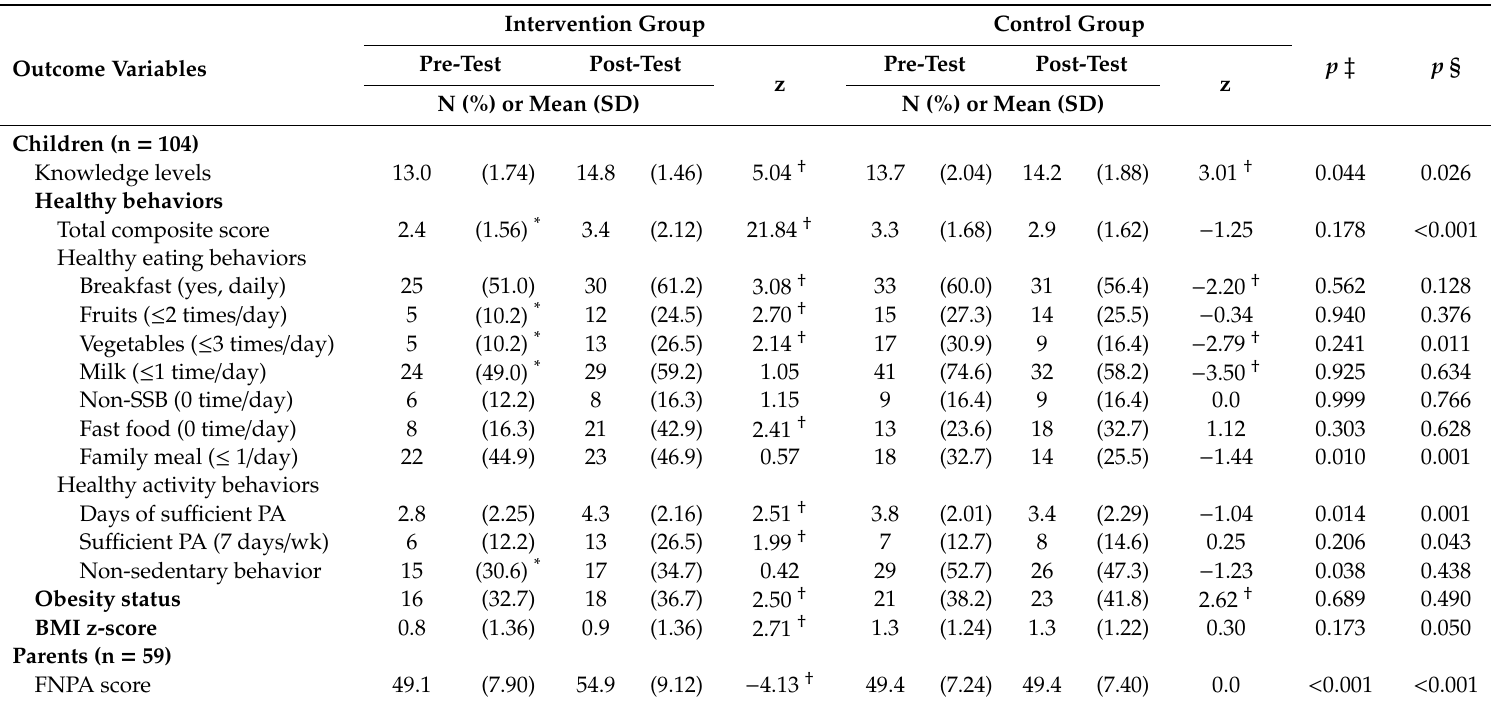
Table 3. E ff ects of the Three Healthy Program for socioeconomically vulnerable children and their parents.